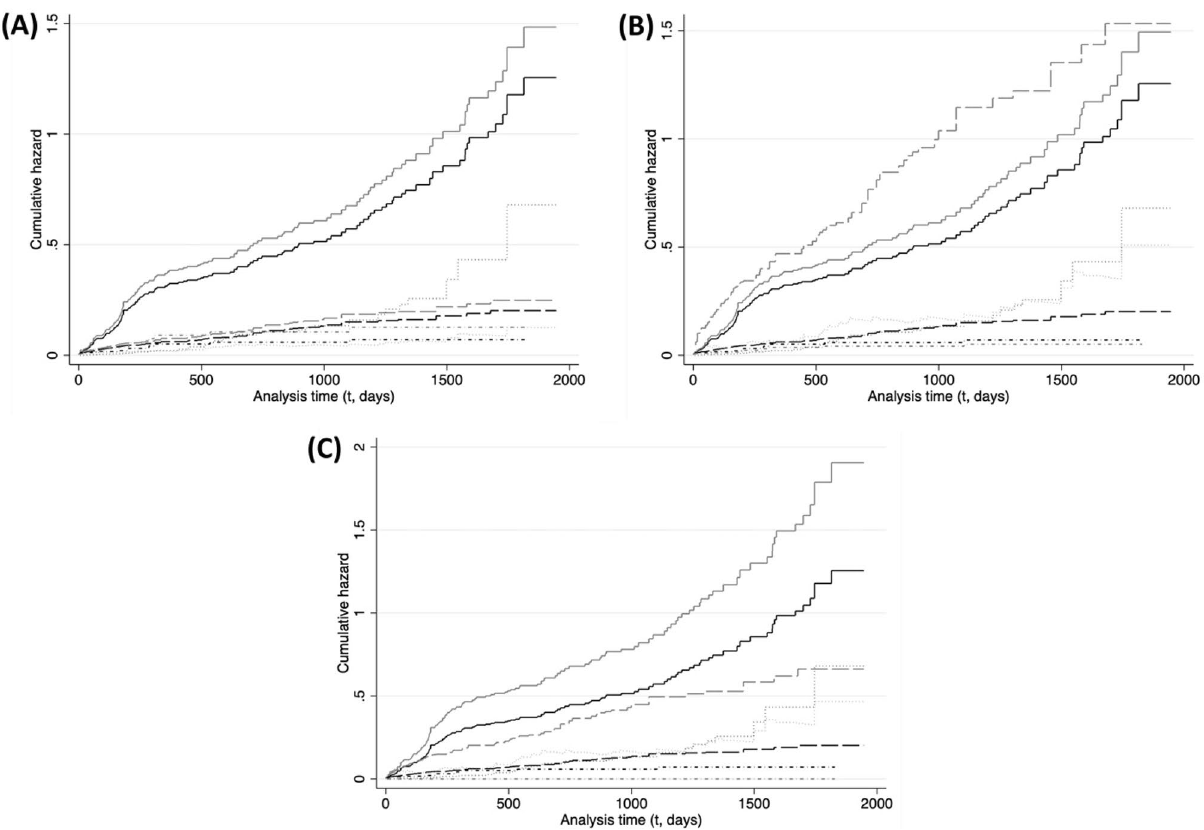
Figure 1. Endpoint-specific cumulative hazard over monitoring time (in days) during strict protection periods ( lib_kill = 0) derived from endpoint-season specific hazards obtained from our preferred joint stratified Cox model (Model 3, Table 1) for n = 495 adult monitored wolves in Wisconsin, USA (1979–2012). Each panel corresponds to a season (( A ) hunt/hound , ( B ) hunt/hound/snow , ( C ) snow ) and illustrates the baseline (black curves) and seasonal (gray curves) cumulative hazards for our endpoints of interest: LTF (solid), reported poached (longdash), legal killing (dash-dot) and natural